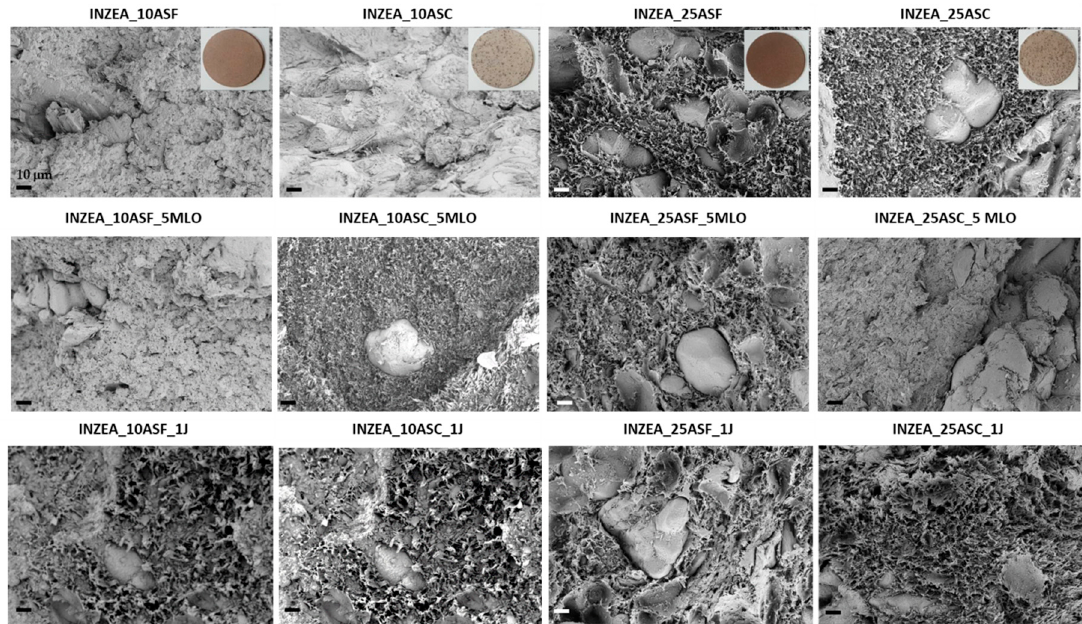
Figure 4. FESEM images of INZEA-based biocomposites with 10 and 25 wt % of ASP at the two grinding levels (fine, coarse), with or without compatibilizers.